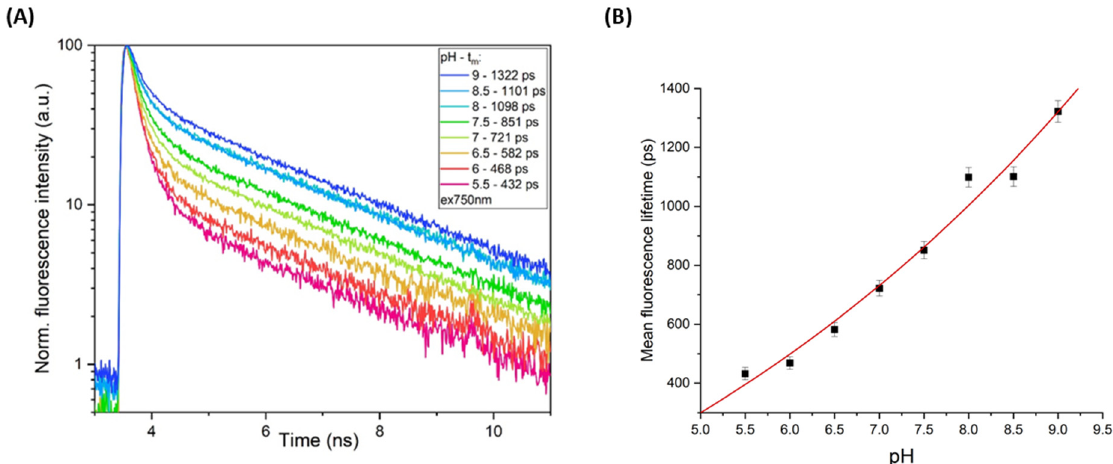
Figure 2. The pH-dependent photobehavior of EGFP-Y145L/S205V recorded by time-resolved fluorescence spectroscopy upon two-photon 750 nm excitation. ( A ) Normalized fluorescence decay kinetics at different pH levels, varying from pH = 5.5 to pH = 9.0. The mean lifetime values and the color legend are in the inset in the top right area. ( B ) The graph describing the dependence of the mean lifetime on the pH.